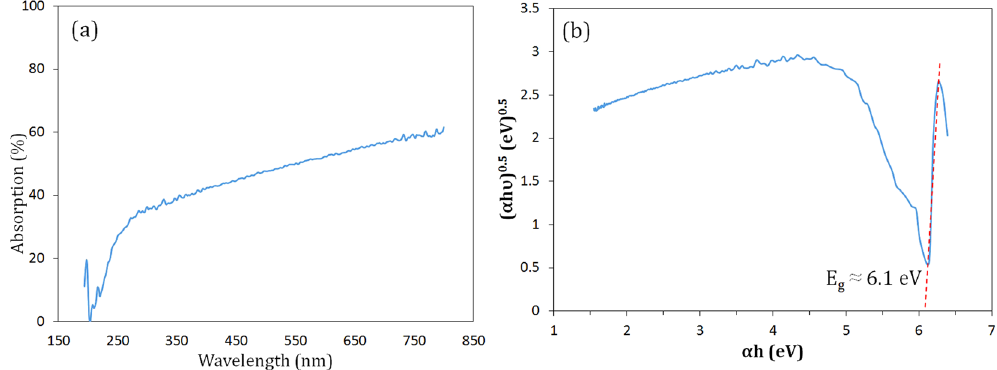
Figure 11. ( a ) UV-vis absorption spectrum of sample M23 after combustion and the leaching treatment. ( b ) Plot of ( α h υ ) 0.5 versus h υ to yield the band gap